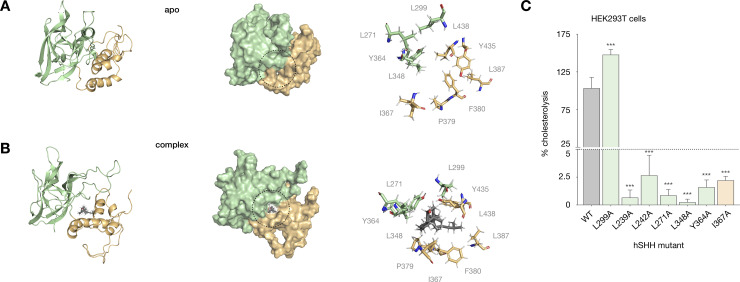
Binding site residues in a cholesterol-Hog complex affect cellular cholesterolysis.(A) Cartoon and surface representations of the apo hSHH Hog model; the Hint-SRR-cholesterol interface is indicated by a dashed black circle. (B) Cartoon and surface representations of the cholesterol-Hog complex, showing cholesterol non-covalently bound to the Hint-SRR interface. For A and B, the expansions shows residues that remain within 5 Å of cholesterol in the cholesterol-Hog complex during a 400 ns MD equilibration. (C) Relative cholesterolysis efficiency of full-length hSHH and mutant proteins overexpressed in HEK293T cells, evaluated by quantitative Western blot. Values are the average of 3–9 biological replicates ± s.d, one-way ANOVA, F(6,37) = 240.9, P value P < 0.001, Dunnett’s multiple comparisons test, a = 0.05, ***p < 0.001.